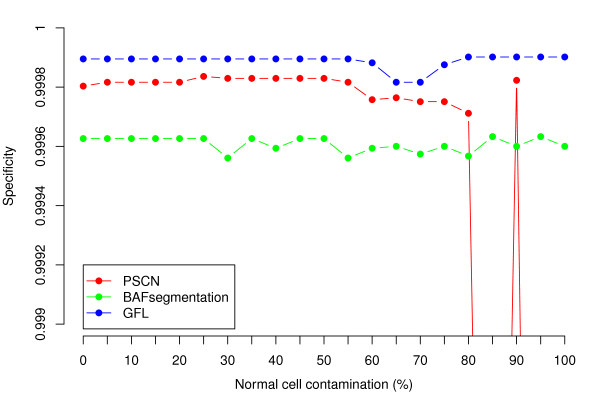
Specificity as a function of percentage contamination by normal cells. Note that [53] reports better performance of PSCN in dealing with contamination levels of 85%, 95% and 100%.